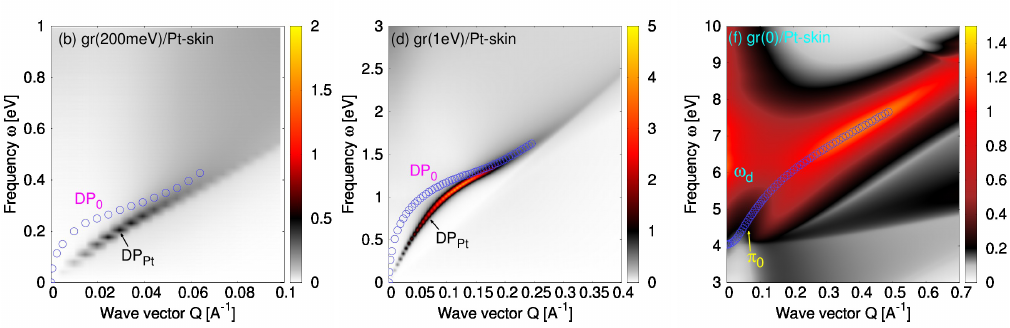
Figure 2. The low-energy (IR) energy loss function (ELF) intensities, −(cid:61) ( 1/ (cid:101) ) , in ( a ) gr( E F = 200 meV)/vacuum and ( b ) gr( E F = 200 meV)/Pt-skin interfaces, the intermediate-energy (VIS) ELF intensities in ( c ) gr( E F = 1 eV)/vacuum and ( d ) gr( E F = 1 eV)/Pt-skin interfaces and high-energy (UV) ELF intensities in ( e ) gr( E F = 0)/vacuum and ( f ) gr( E F = 0)/Pt-skin interfaces. The blue circles in the panels ( b , d , f ) show the positions of the ELF intensities maxima in the unsupported graphene cases displayed in the panels ( a , c , e ), respectively. The graphene Fermi energy E F is given relative to the Dirac